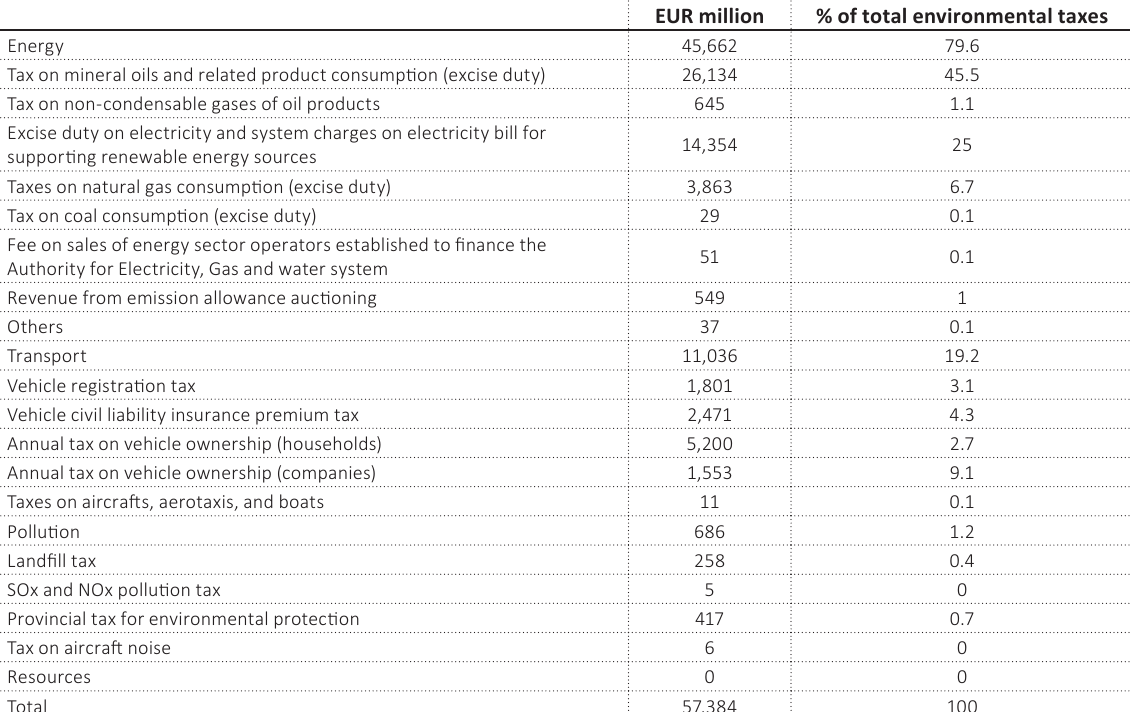
Table 1. Revenue breakdown of environmental taxes in Italy in